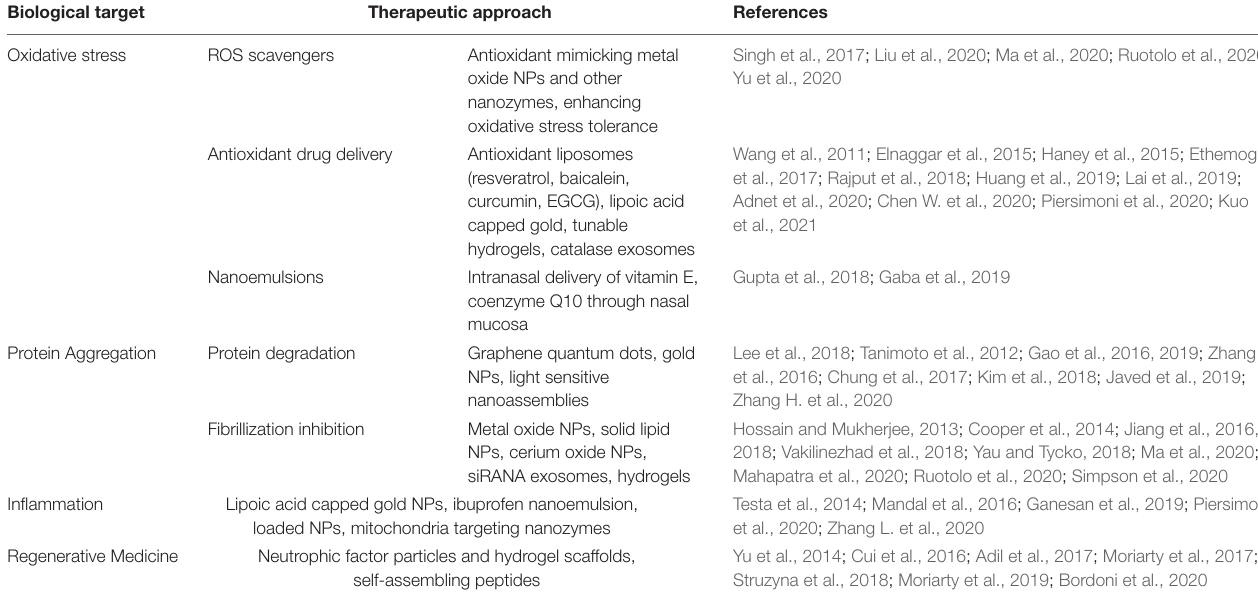
TABLE 1 | Nanotechnology addressing mechanisms of PD and